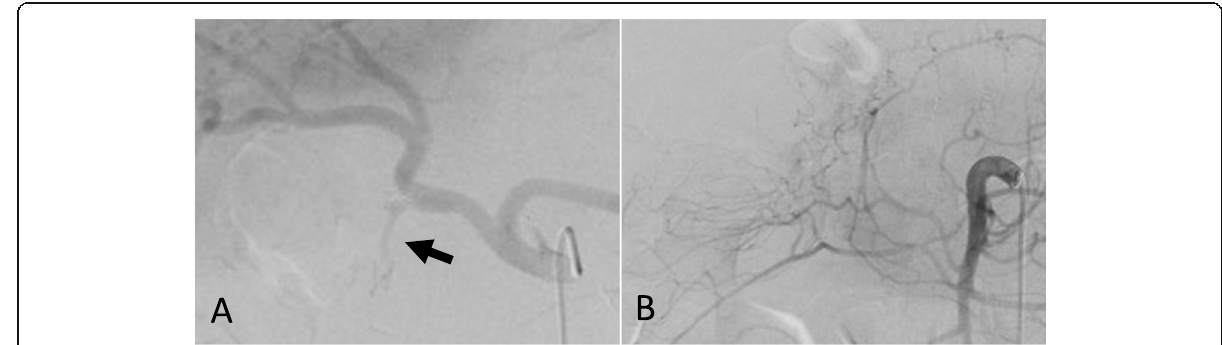
Fig. 3 Angiography findings. Angiogram revealing no apparent pseudoaneurysm or extravasation from the celiac artery, splenic artery, and gastroduodenal artery (arrow) and their branches ( a ) as well as inferior pancreaticoduodenal artery branching from the superior mesenteric artery ( b )